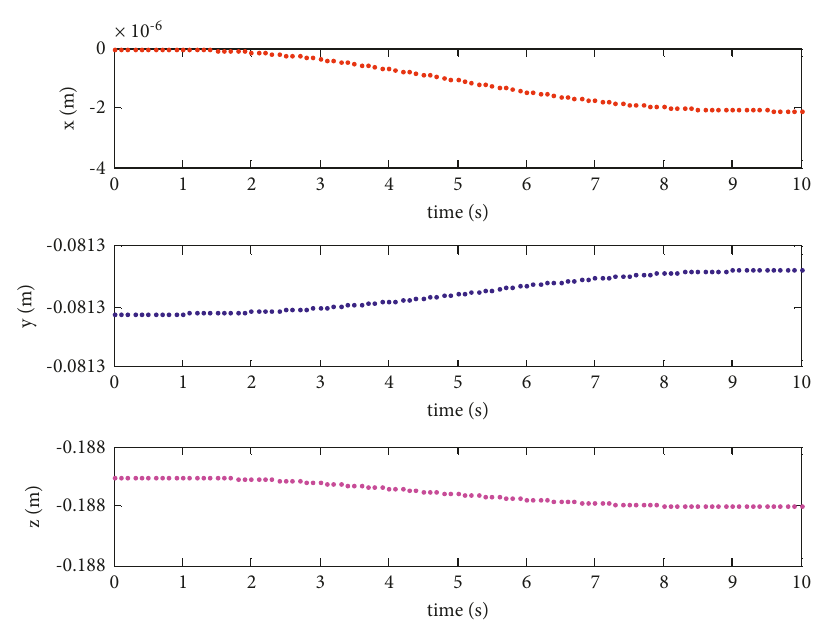
Figure 9: The position of the base obtained by the PSO